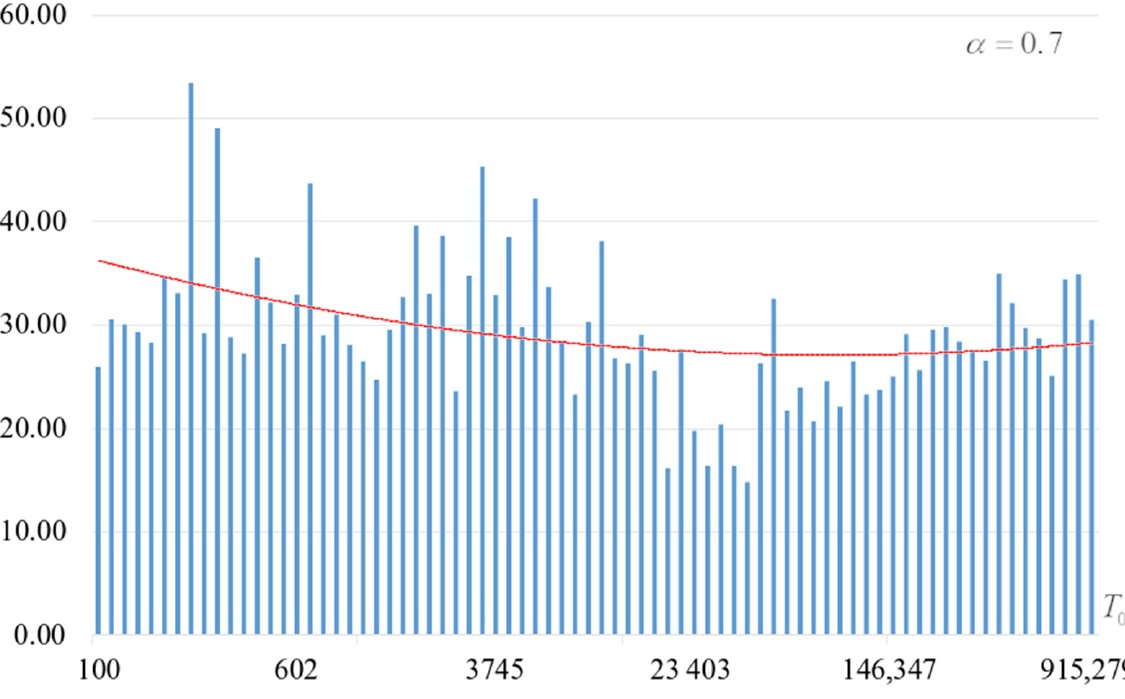
Figure 7. Average time (s) of target S-box formation at 𝛼 = 0.7 .